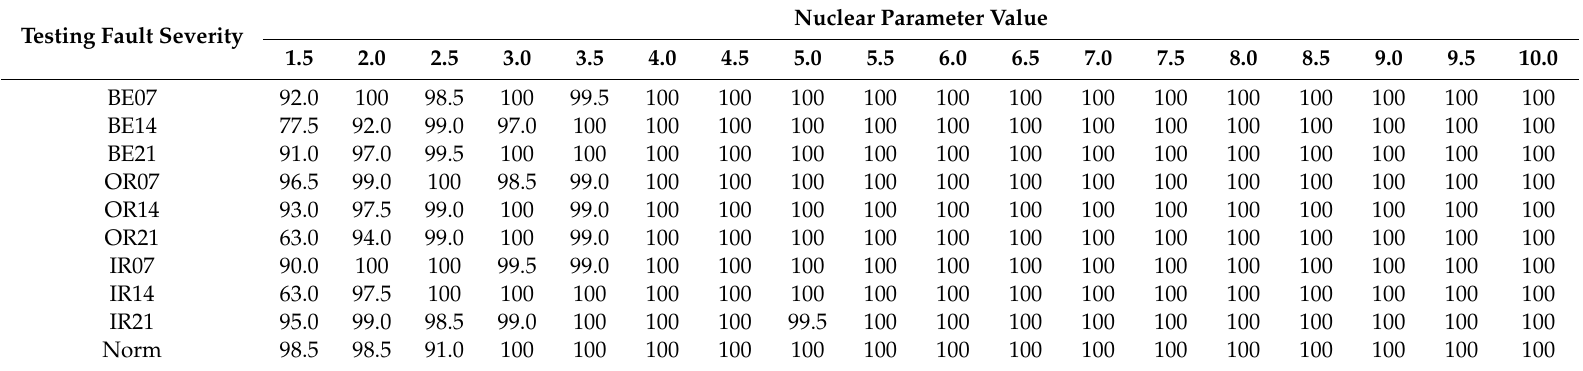
Table 15. The influence of nuclear parameter selection of the mRVM 1 _conv 1 on fault identification accuracy of the rolling bearing (%). Testing Fault Severity